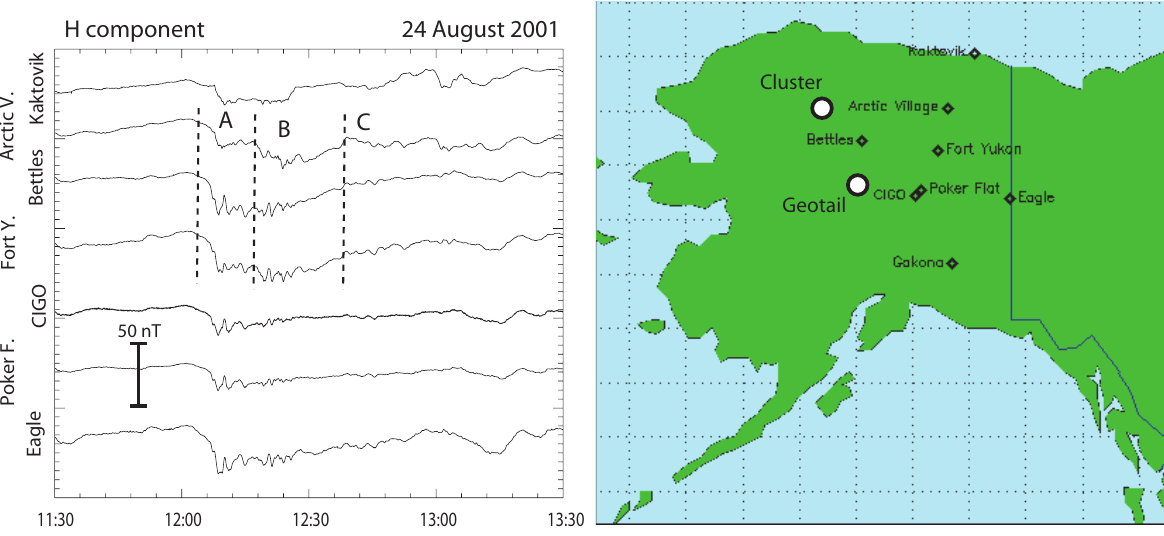
Fig. 6. Right: A geographic map with Cluster’s and Geotail’s footprints (using T96 for the mapping) together with the GIMA ground stations.